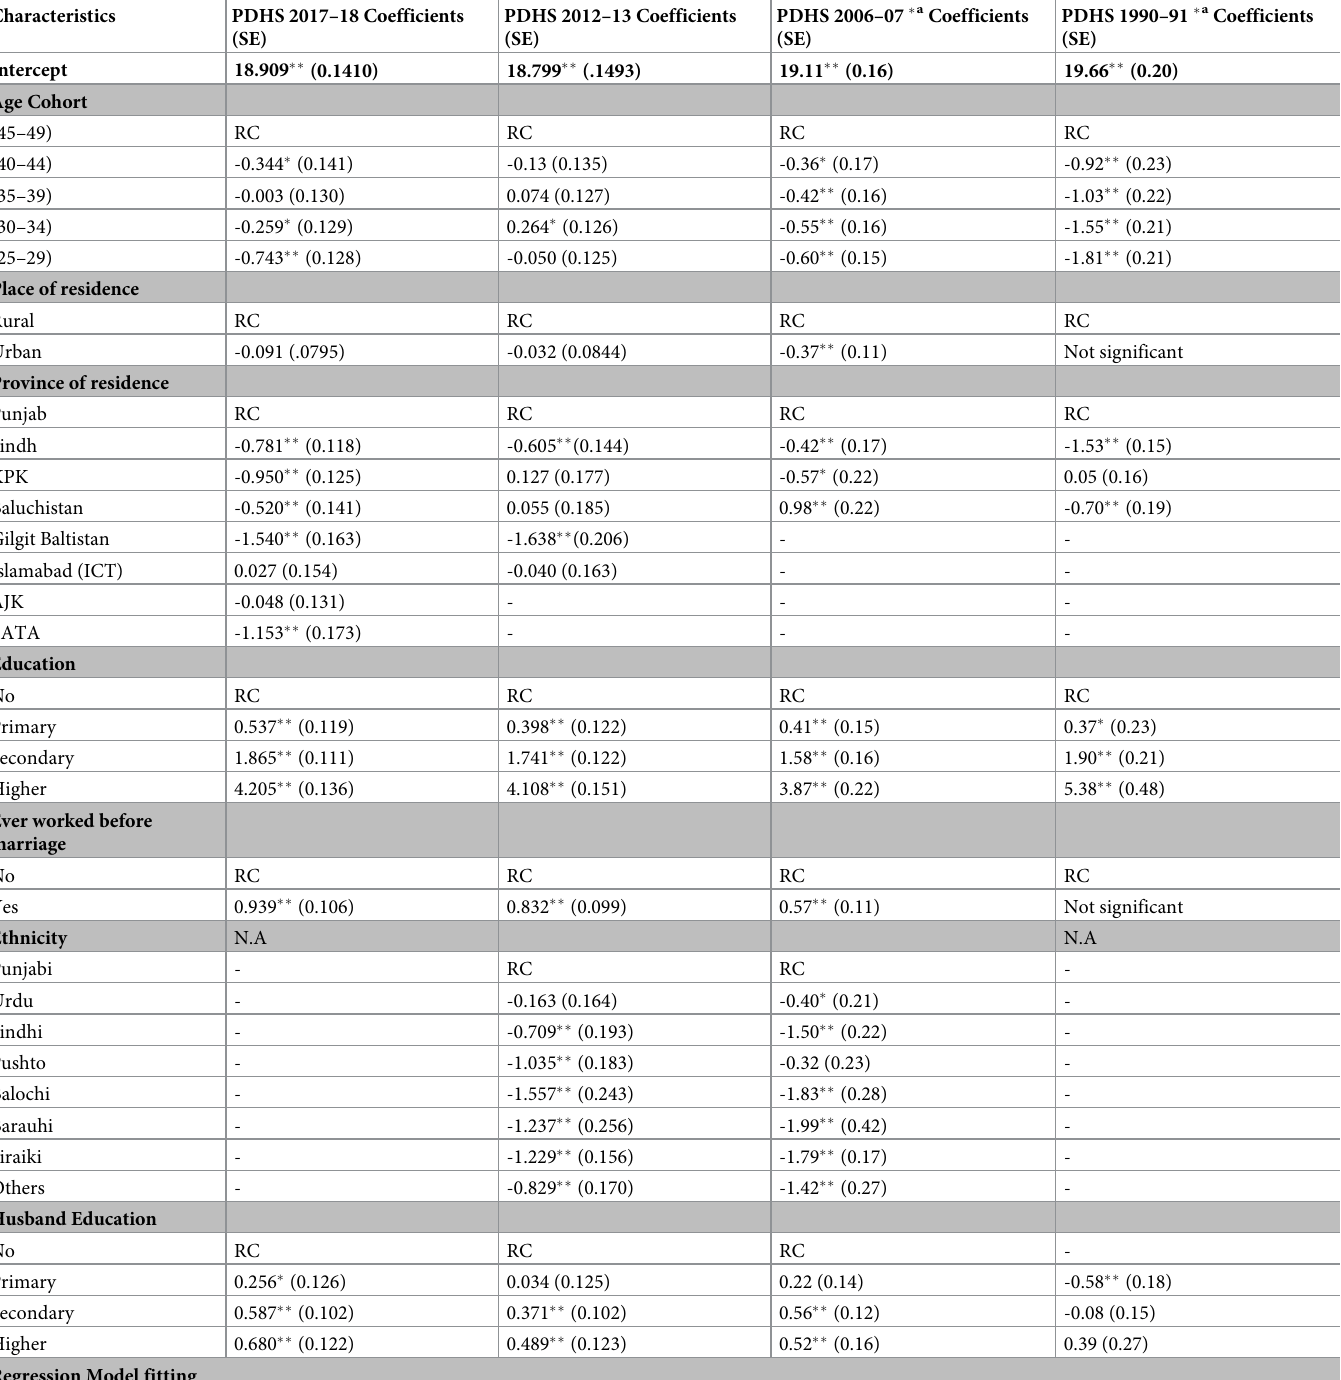
Table 6. Multiple regression estimates of the factors associated with age at first marriage of currently married women (PDHS 1990–91, PDHS 2006–07, PDHS 2013–14 and PDHS 2017–18).